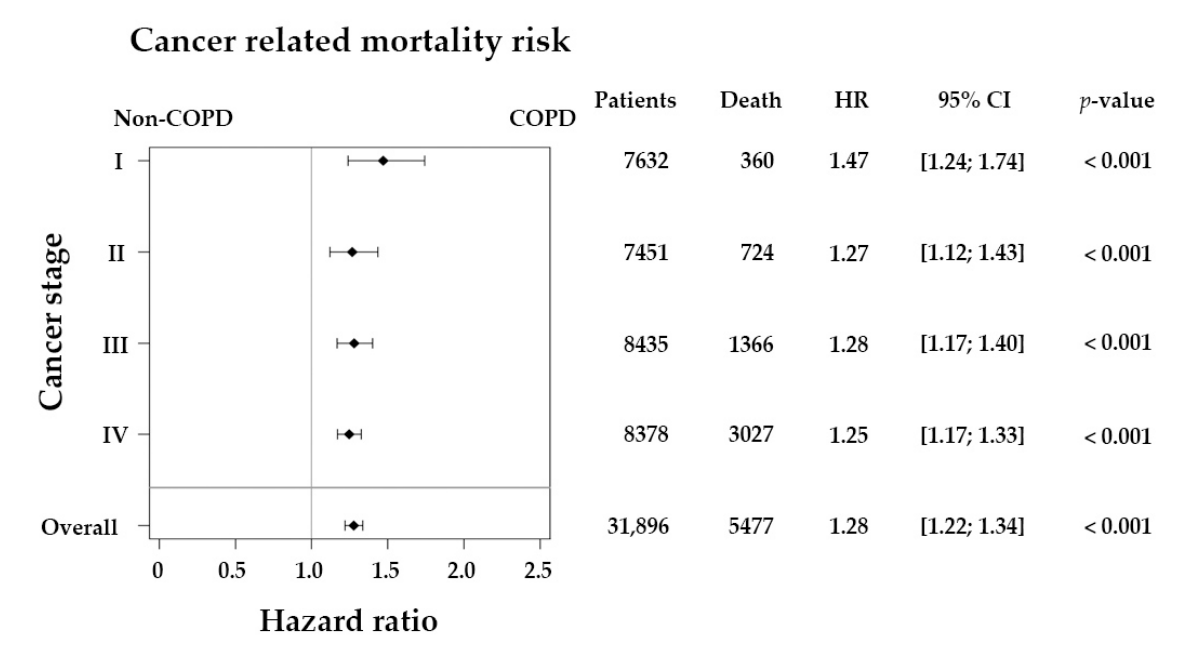
Figure 2. Five-year Cox-adjusted survival curves of patients with colorectal cancer (CRC) and with or without the preex- isting chronic obstructive pulmonary disease (COPD) from this matched cohort study. Total 31,896 patients with CRC were matched by comorbidities using PSM with a 2:1 ratio, and the total number is reduced to 13,707 patients. Patients were followed up for 5 years after being diagnosed with CRC. The red line displays the Cox-adjusted survival curve of patients with CRC plus preexisting COPD, and the black line represents the control group.